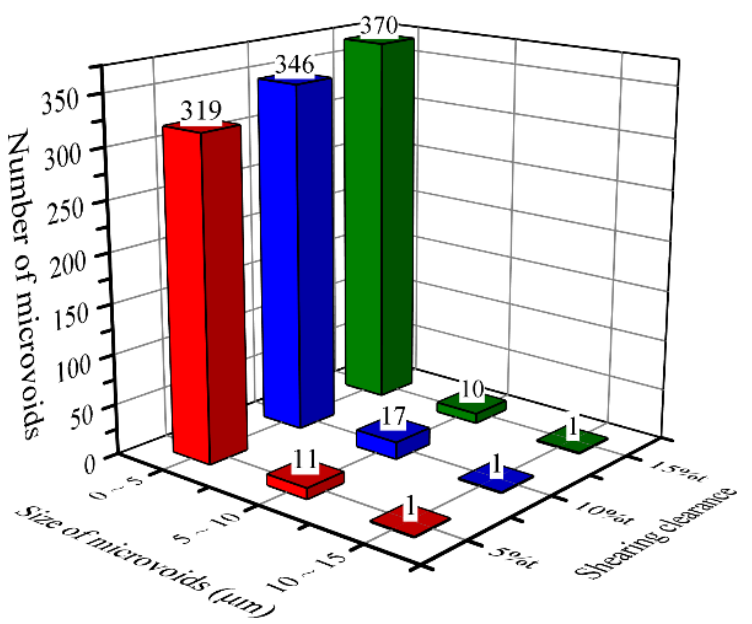
Figure 16. Number of microvoids generated in the sheared edge under the shearing clearances of 5%t, 10%t, and 15%t.